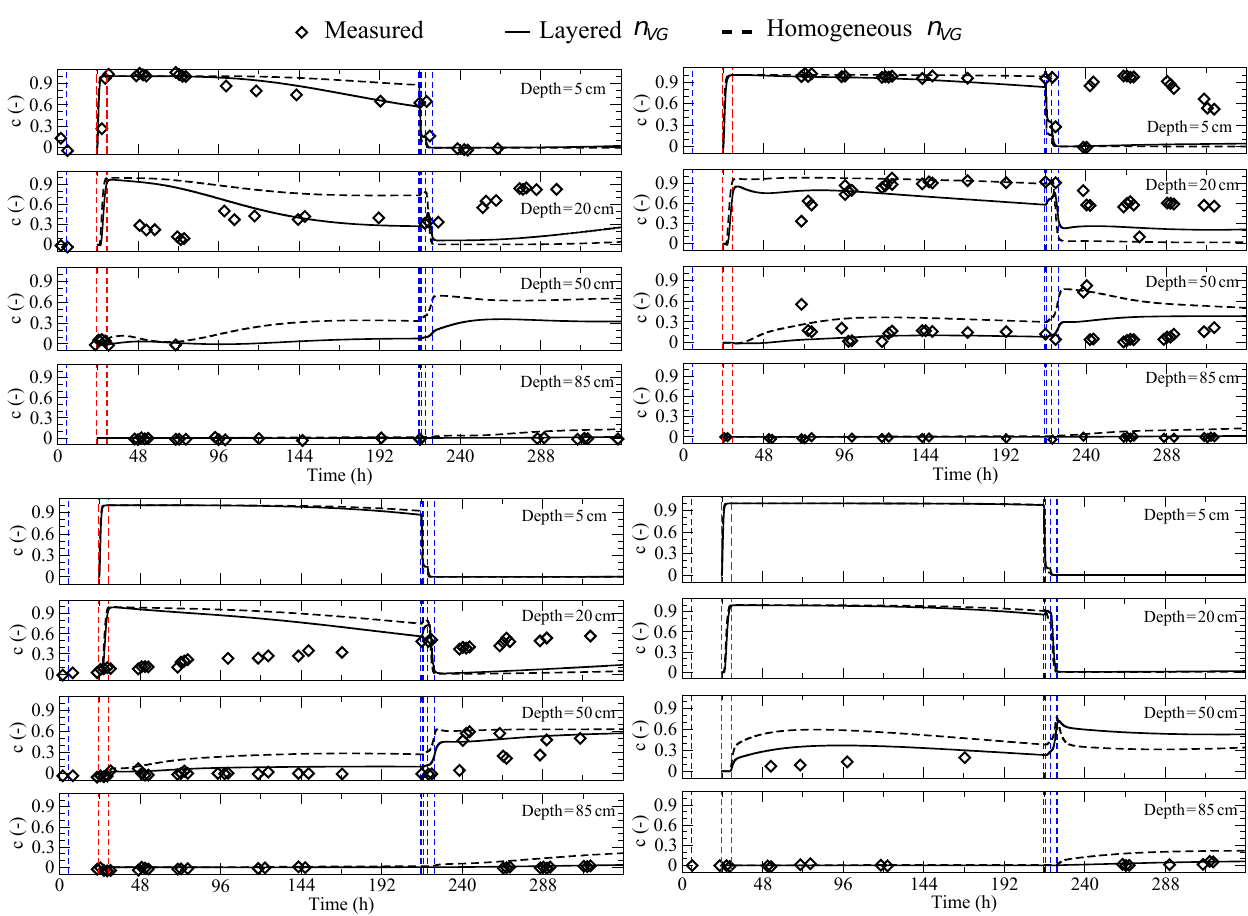
Figure 14. Distributed (internal state) hydrological response for the tracer concentration breakthrough curves at 5, 20, 50, and 85cm depths from the surface for four locations on the LEO-1 hillslope: point a (top left), point b (top right), point c (bottom left), and point d (bottom right) of Fig. 2. There were no tracer concentration measurements at 5cm depth for point c and at 5 and 20cm depths for point d. The transport model is run for α l = 0 . 001m and α t = 0 . 0001m. The vertical dashed lines indicate the timing of the three pulses of rain (red when the water is 2 H -enriched and blue when it is